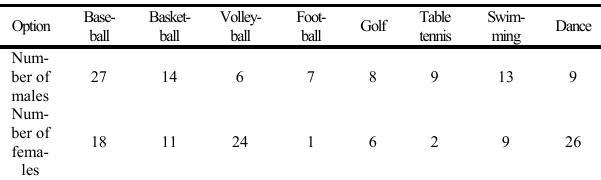
Table 4 Questionnaire for the selection of students